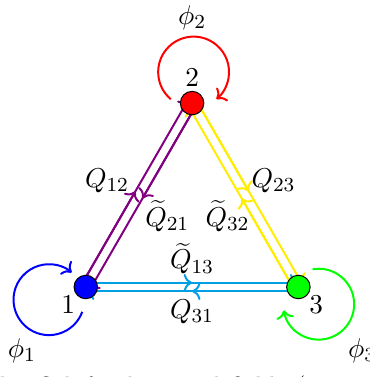
Figure 13 . The Z 3 quiver. The Q bifundamental fields (components of X in N = 4 language) connect the nodes in a clockwise direction while the ˜ Q bifundamental fields (components of Y in N = 4 language) connect the nodes in an anticlockwise direction. The φ adjoint fields (components of Z in N = 4 language) return to the same